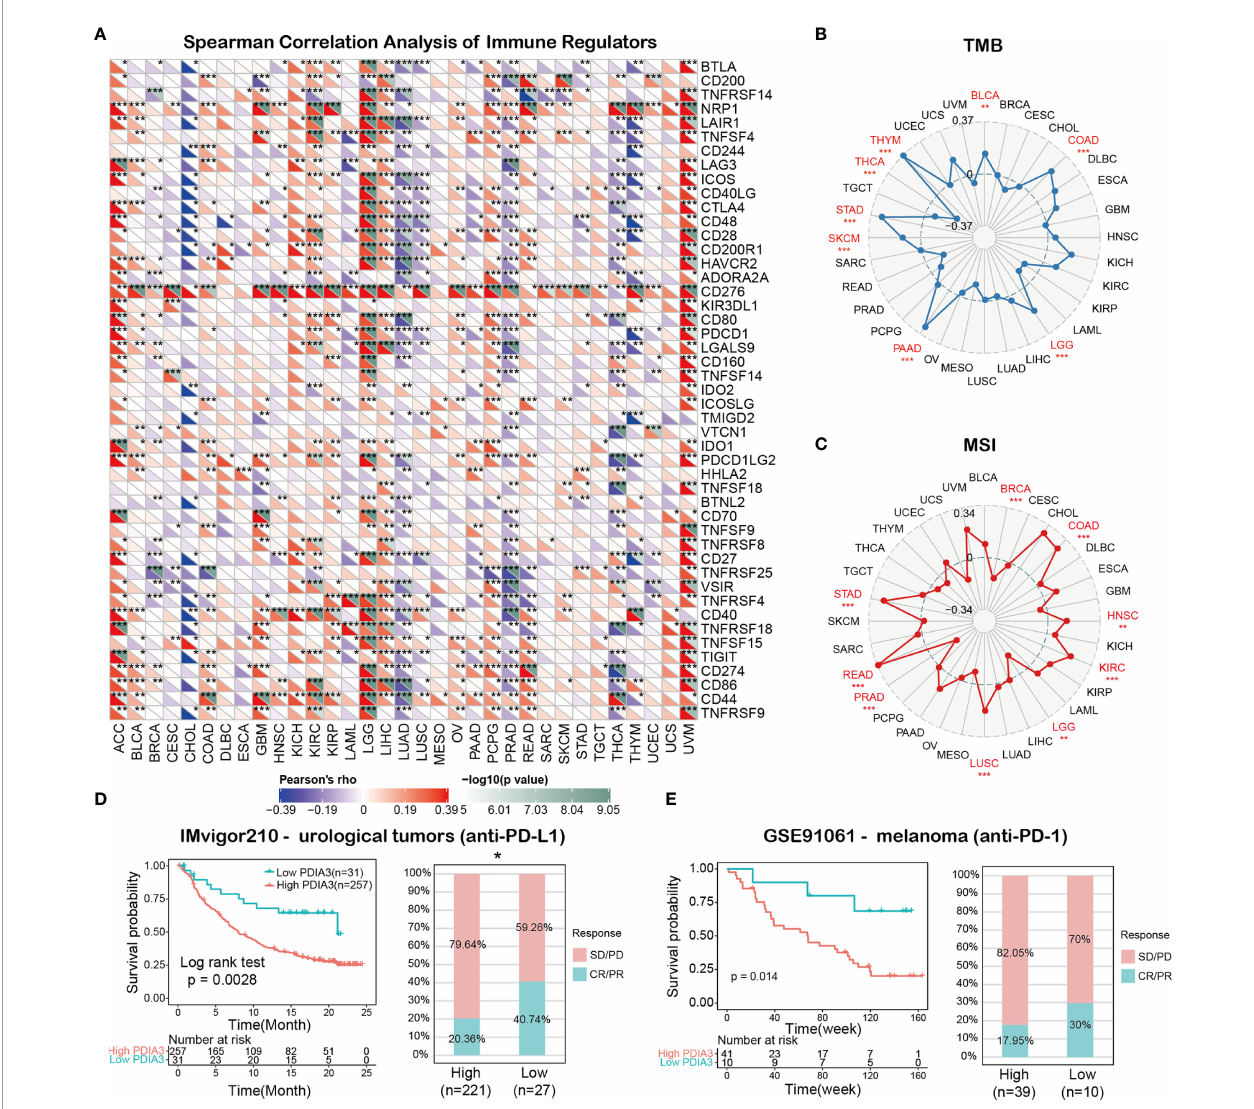
FIGURE 6 | (A) The spearman correlation heatmap shows the correlations between the PDIA3 expressions and the 47 types of immune regulators in pan-cancer. Red represents positive correlation and blue represent negative correlation. (B) Correlations between PDIA3 expression and tumor mutation burden in pan-cancer. (C) Correlations between PDIA3 expression and microsatellite instability in pan-cancer. (D) Kaplan-Meier curves for low- and high-PDIA3 patient groups in IMvigor210 cohort (anti-PD-L1, urological), and the fraction of urological tumors patients with response to anti-PD-1 therapy in low- and high-PDIA3 subgroups of IMvigor210 cohort. (E) Kaplan-Meier curves for low- and high-PDIA3 patient groups in GSE91061(anti-PD-L1, melanoma), and the fraction of melanoma patients with response to anti-PD-1 therapy in low- and high-PDIA3 subgroups of GSE91061. The labelled asterisk indicated the statistical p value (*p < 0.05, **p < 0.01, ***p <